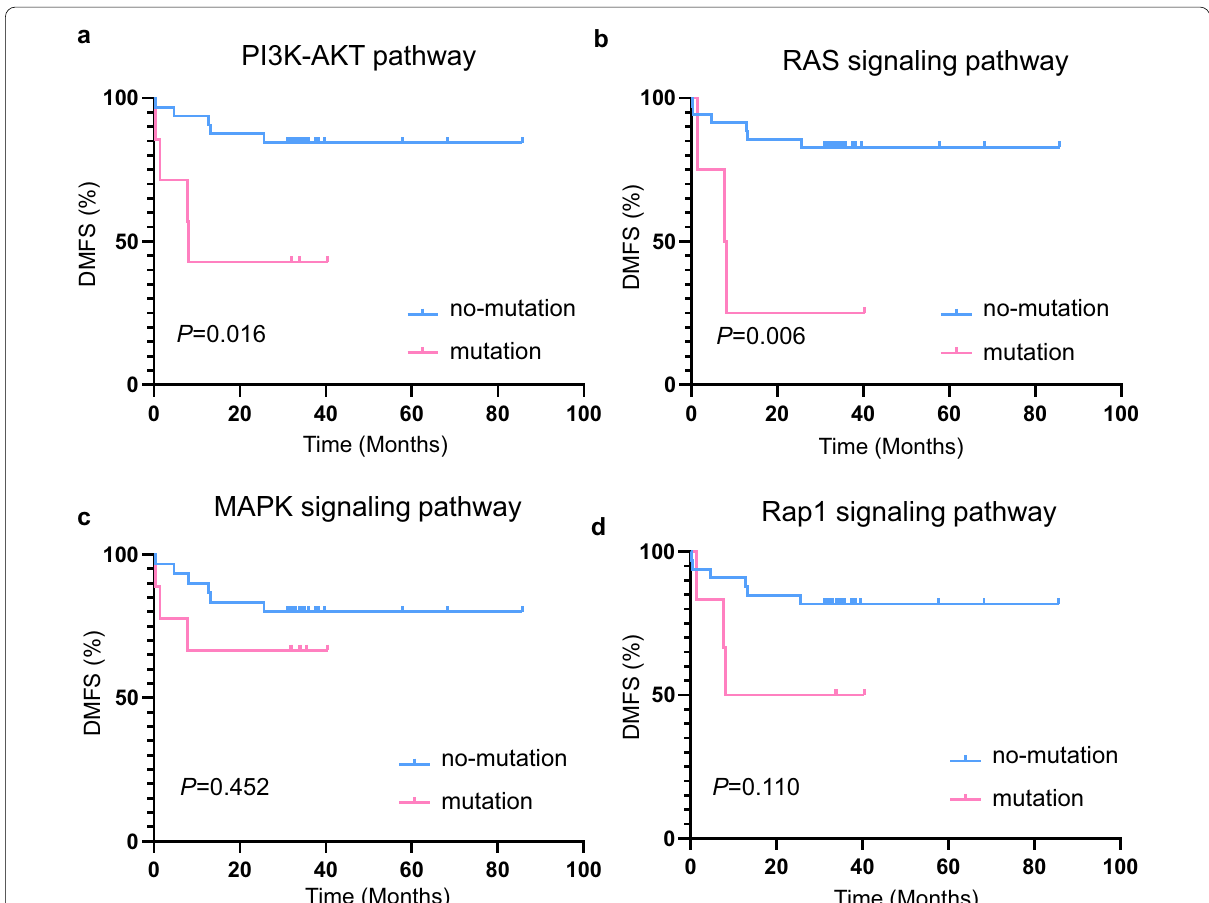
Fig. 4 Kaplan–Meier estimates comparing distant metastasis-free survival of patients with nasopharyngeal carcinoma (NPC). a With and without an altered PI3K-Akt signaling pathway. b With and without an altered Ras signaling pathway. c With and without an altered MAPK signaling pathway. d With and without an altered Rap1 signaling